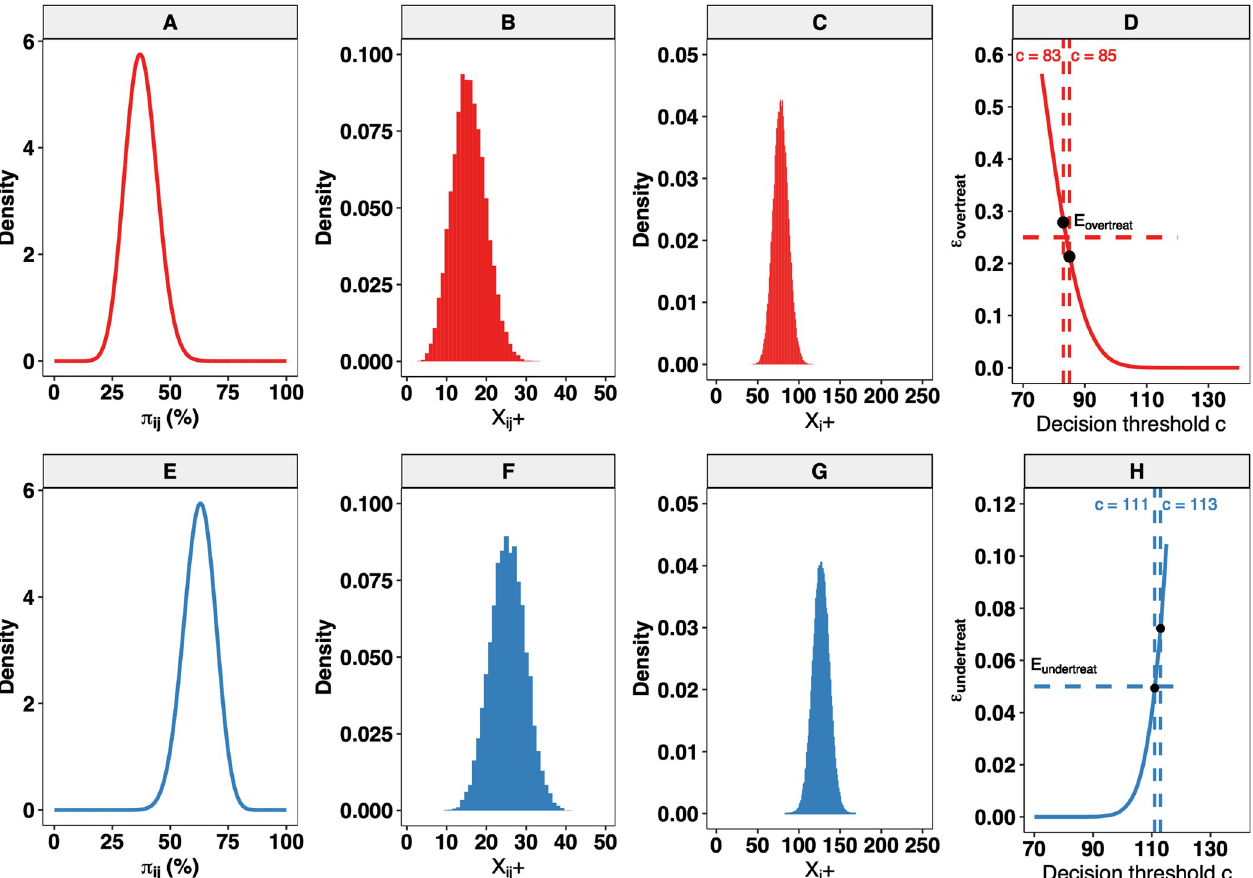
Fig 3. Determination of the decision cut-off c based on 2-stage LQAS framework allowing for imperfect tests. This figure describes the simulation framework to determine the decision cut-off c that allows for adequate ( E = 25 % and E = 5 %) decision-making at a true underlying prevalence overtreat undertreat π i at the implementation unit i equal to 37.5% ( LL ) and 62.5% ( UL ) when an imperfect theoretical diagnostic test D ( se d = 80 % and sp d = 98 %) was deployed to = 5 and n = 50 subjects per cluster. We fixed the intra-cluster correlation ρ = 0.02 at both limits of the grey zone. The bottom row graphs screen n clust sub i ( Panels A–D ) illustrate the process for the lower limit of the grey zone, whereas the bottom row graphs ( Panels E–H ) show this for the UL of the grey zone. The horizontal dotted line in Panel D represents the E , wherein Panel H represents E . The dotted vertical lines in these panels represent the overtreat undertreat decision cut-off c and the bullet the ε overtreat ( Panel D ) and ε undertreat ( Panel H ). All graphs are based on the same set of 10,000 Monte Carlo simulations.